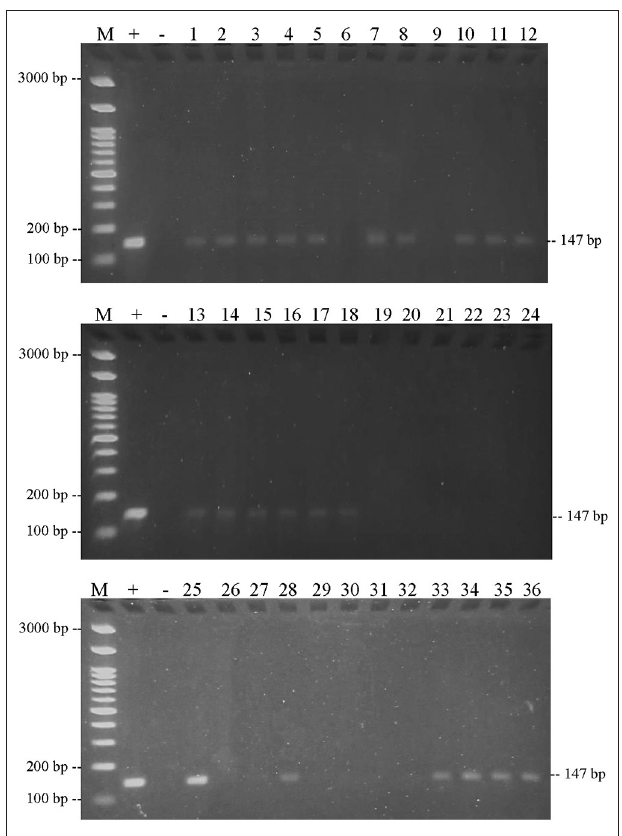
FIGURE 10 | Results of PCR amplification of meatball samples in Boyolali Regency with pork primers and electrophoresis on 2% agarose gels. (M) DNA marker 100 bp; ( + ) positive control meatballs; (–) negative control (no template control); samples were coded with numbers